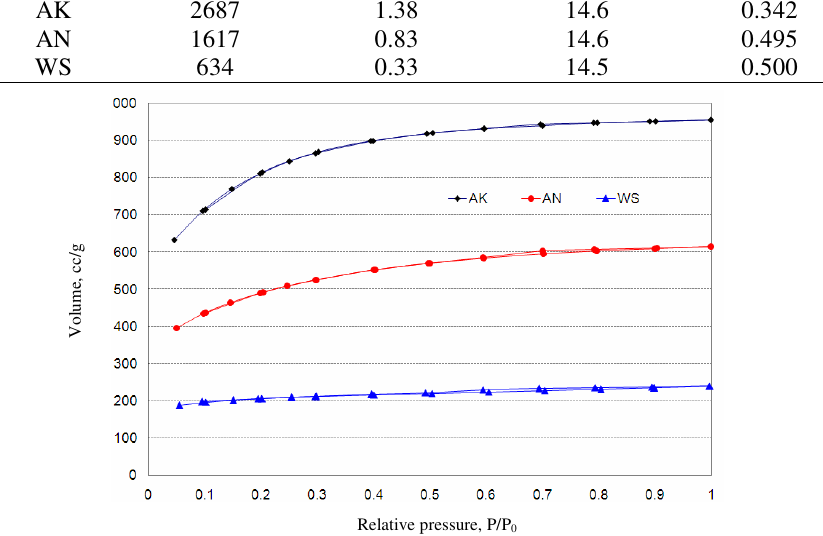
Figure 1. Nitrogen isotherms of activated carbons